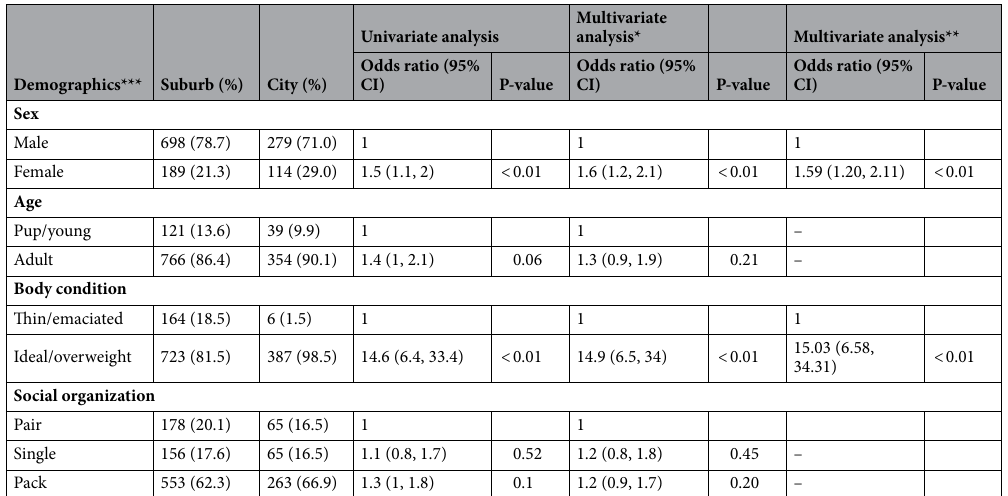
Table 1. Multiple logistic regression analysis of the characteristics of free-roaming dog population between the city and suburbs of Kerman, presented as odd ratios (OR) and 95% confidence intervals (CI). *Logistic regression with Enter/ Forward method. **Logistic regression with Backward method. ***Respectively, sex, age, and body condition of 220, 10 and 14 FRDs were